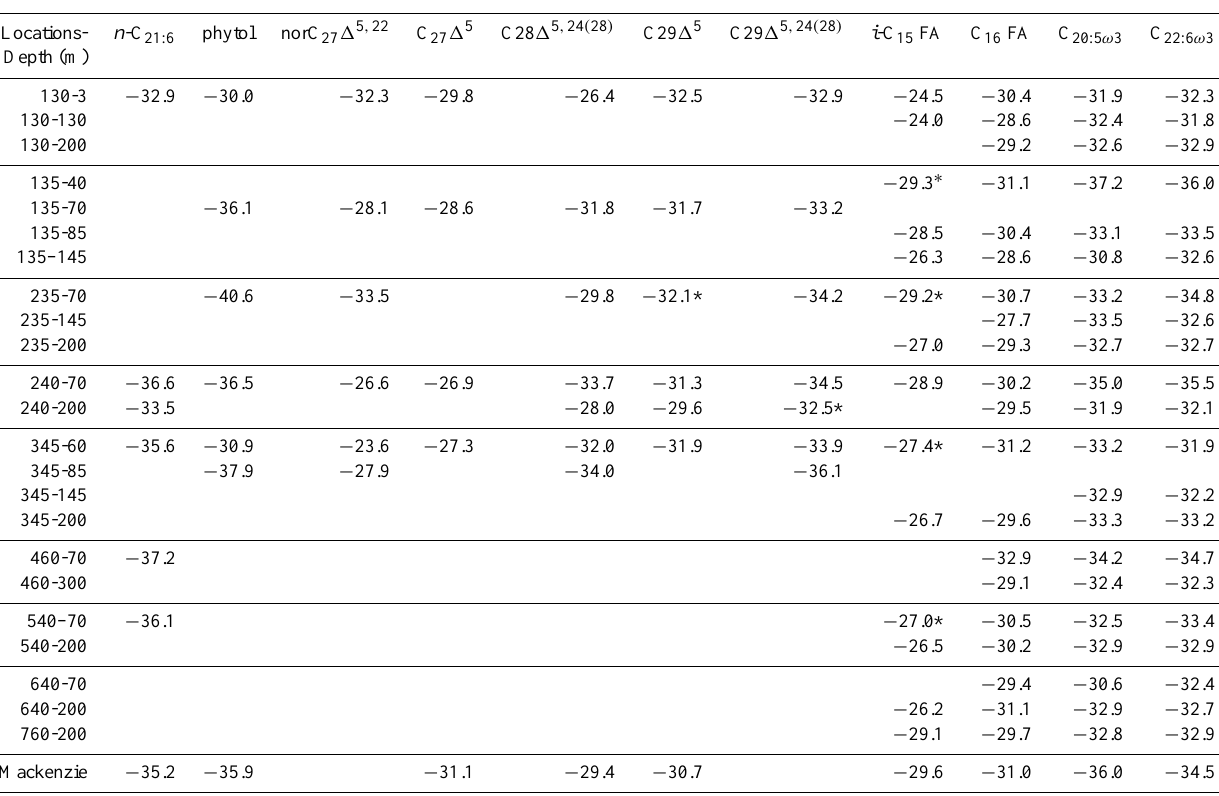
Table 11. Stable carbon isotopic composition ( δ 13 C (‰) average of three replicate injections with S.D. < 0.8) of selected lipid biomarkers in SPM from Beaufort Sea.